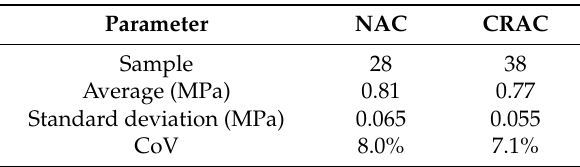
Table 3. Statistical analysis of K